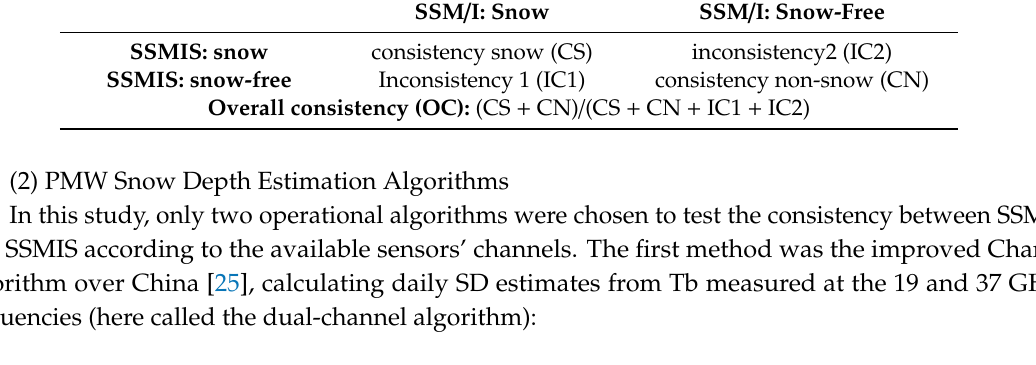
Table 4. Assessment indexes of consistency between SSM / I and SSMIS for snow cover detection. SSM / I: